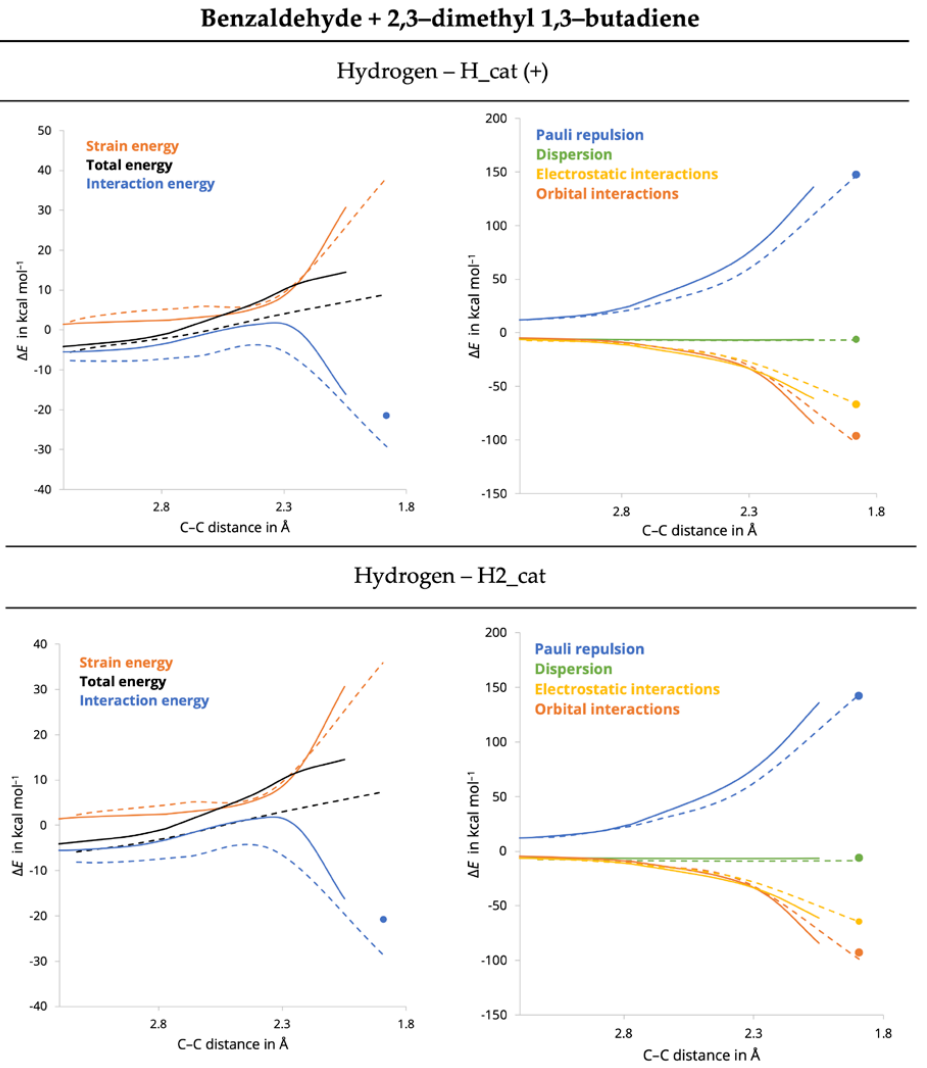
Figure 4. ASM ( left ) and EDA ( right ) analysis of the uncatalyzed and hydrogen-bond-catalyzed reactions between benzaldehyde and 2,3-dimethyl 1,3-butadiene. The solid line represents the reaction without the catalyst, and the dashed line represents the reaction with the catalyst. The dots represent the values for the transition-state geometry of the catalyzed reaction with the catalyst deleted.